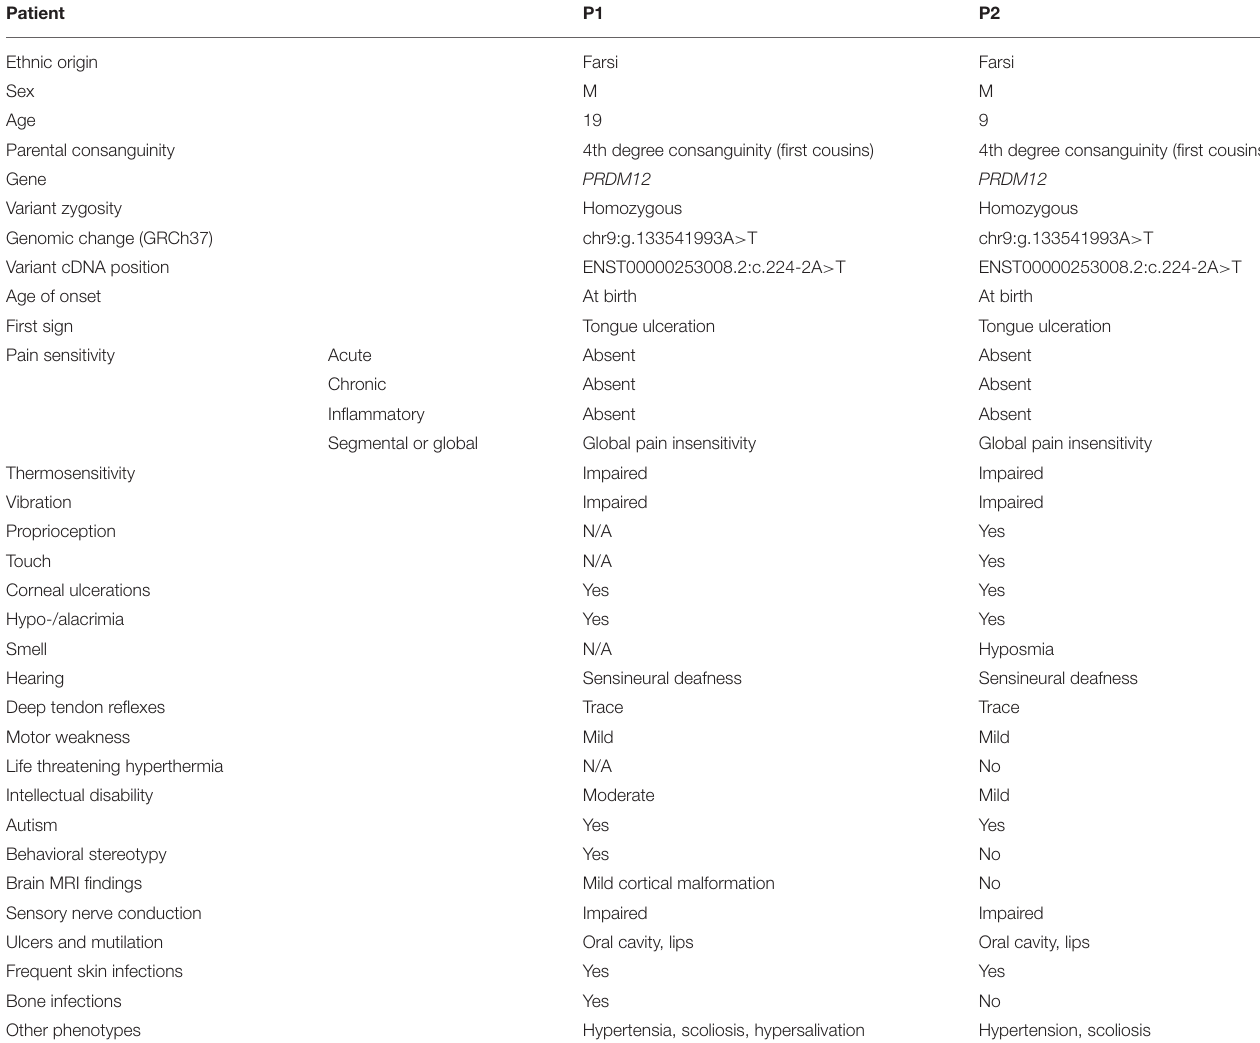
TABLE 1 | Clinical synopsis of patients 1 and